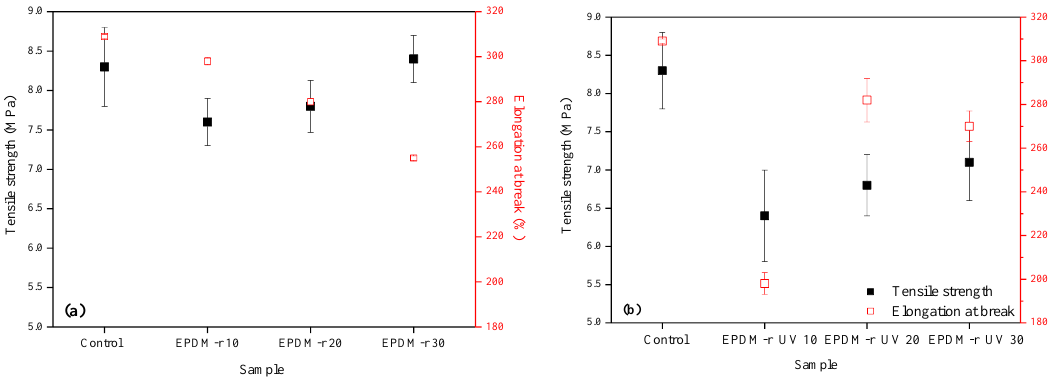
Figure 2. Tensile strength and elongation at break results of the blends: ( a ) EPDM-r and ( b ) EPDM-r UV.